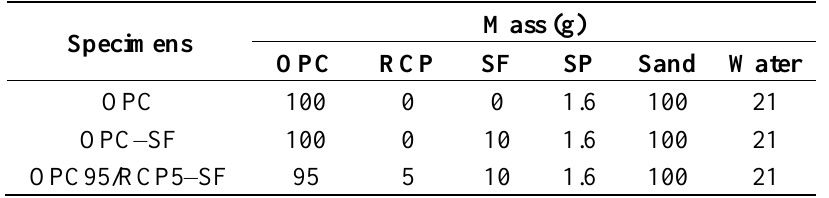
Table 5. Mixing proportion of